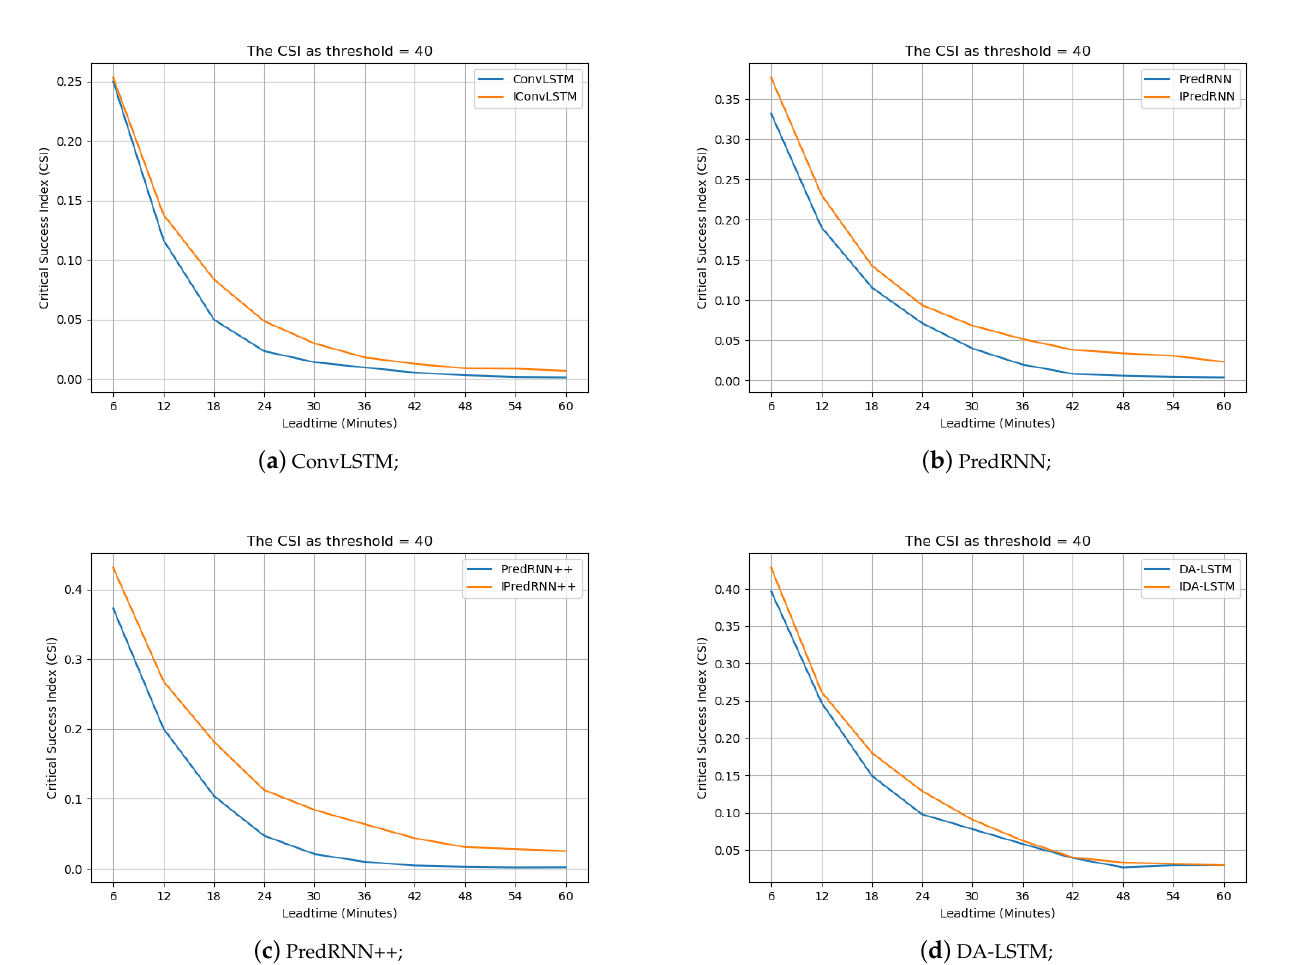
Figure 13. The performance changes against different nowcast lead times in interaction ablation study in terms of CSI as the threshold is 40 dBZ. (Best view in